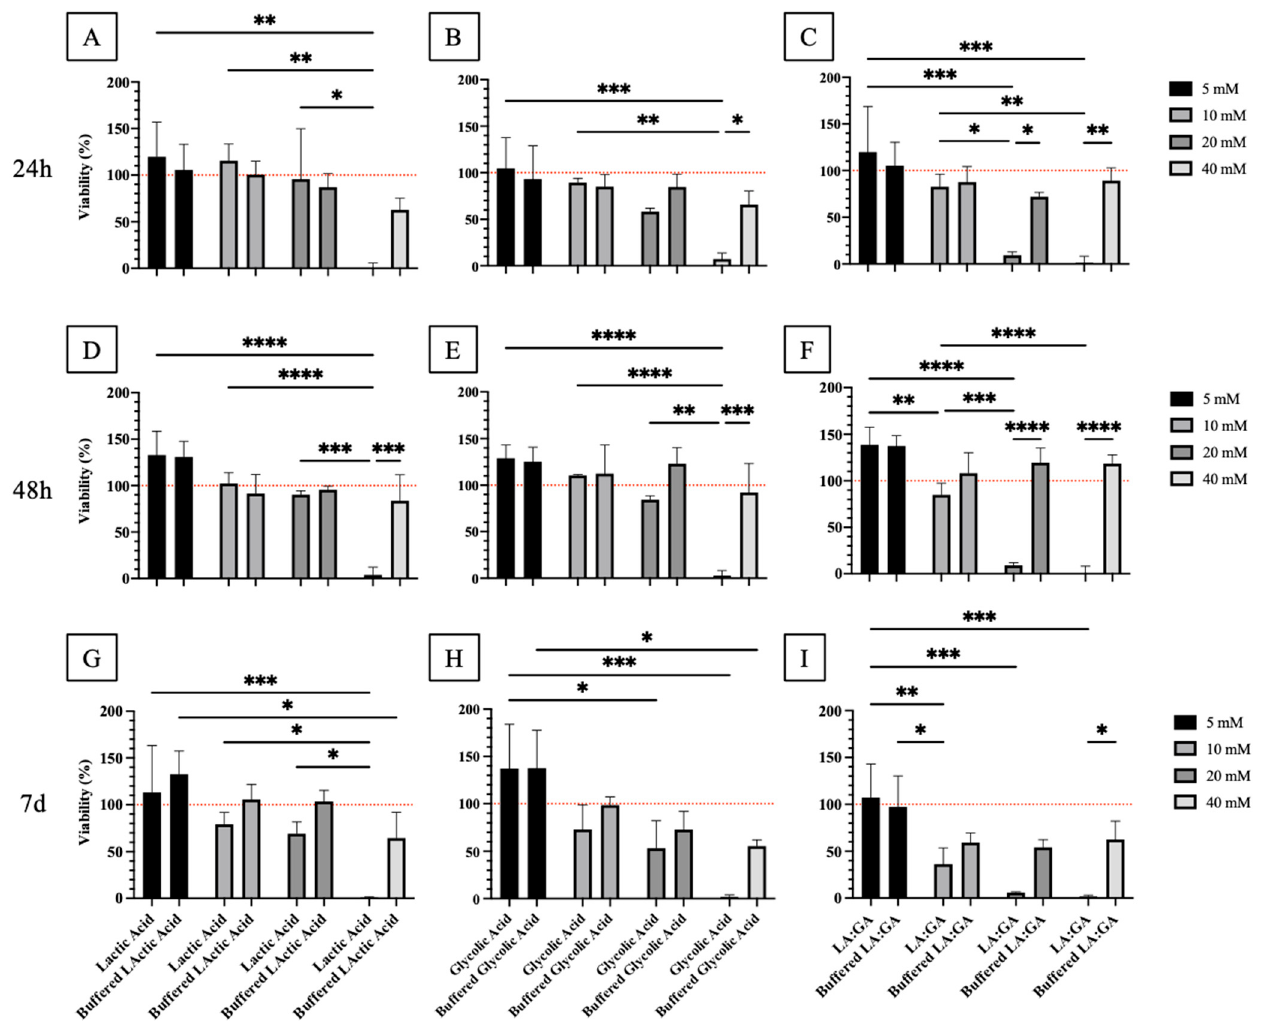
Figure 9. MTT oAECs analysis on the effect of PLGA degradation by-products ( A , D , G ). Lactic acid (LA) and buffered LA ( B , E , H ), glycolic acid (GA) and buffered GA, and ( C , F , I ) LA:GA and buffered LA:GA at different concentrations (5, 10, 20, and 40 mM) at 24 h, 48 h, and 7 d. CTR viability value (100%) has been used as reference (dotted red line). *, **, ***, and **** statistically significant between tested groups ( p < 0.05, p < 0.01, p < 0.001, and p < 0.0001, respectively).